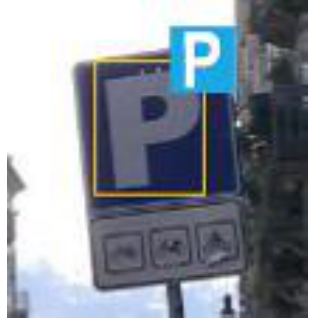
Figure 12. Traffic sign indicating a parking lot reserved to motorcycle, motorbike and bike and the related Mapillary